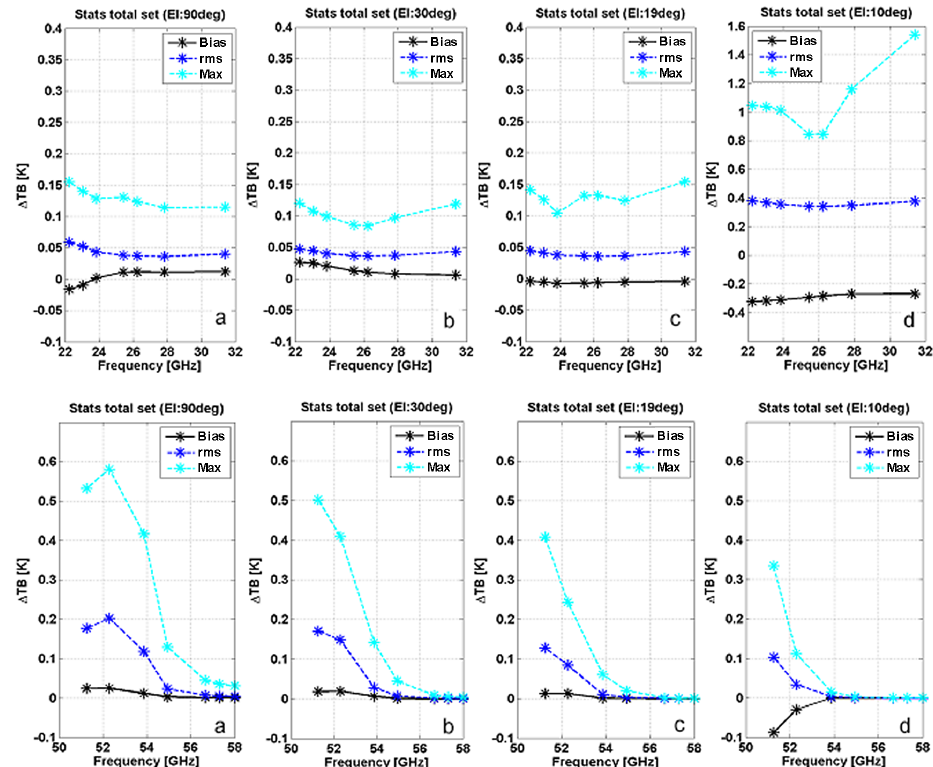
Figure 3. Bias (black solid line), rms (blue dashed line), and maximum (cyan dashed line) of TB difference between RTTOV-gb and LBL R98 (Rosenkranz, 1998) for the dependent 83-profile set and the best training configuration (R98 minus RTTOV-gb). Top panels: K-band channels; bottom panels: V-band channels. Panels (a) , (b) , (c) , and (d) report results at 90, 30, 19, and 10 ◦ elevation angle, respectively. Note that the top panel (d) has a different y axis scale with respect to the other top